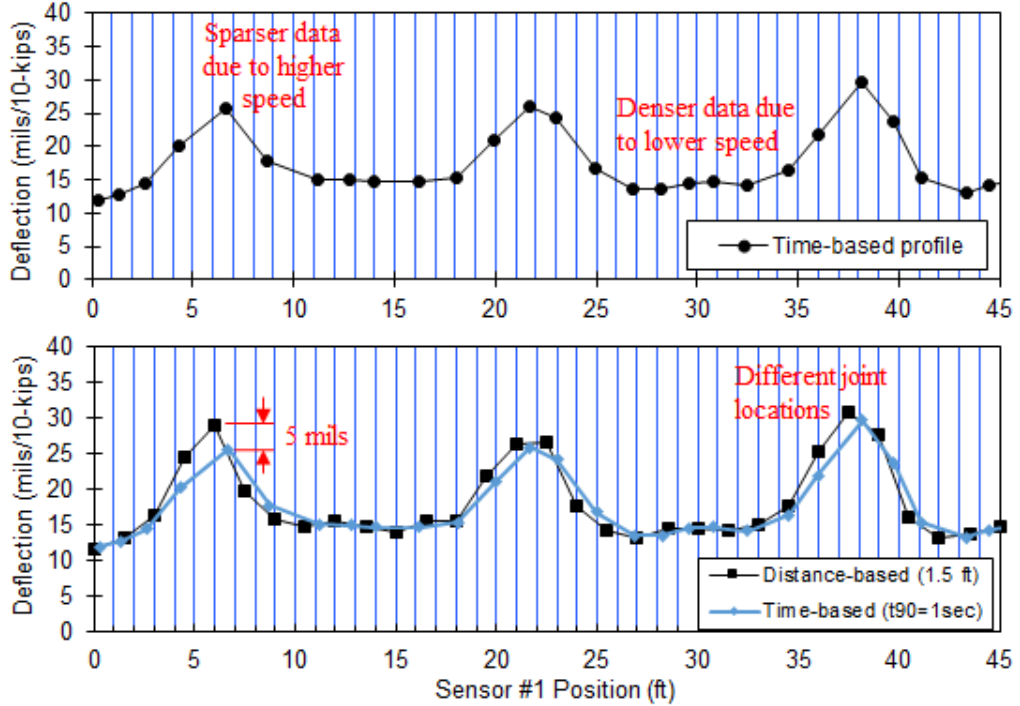
Figure 10. Continuous deflection profiles constructed by the time- and distance-based methods (note: data set collected along a JCP at 1.6 km/h (1 mph)).